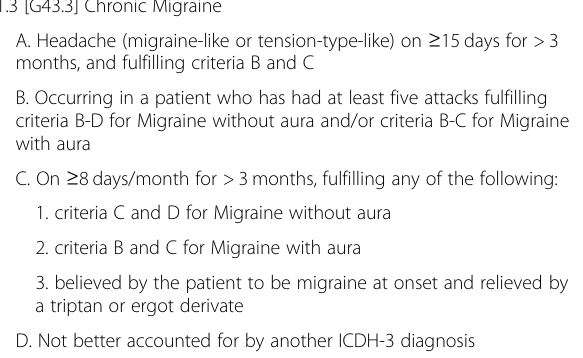
Table 4 Classification of chronic migraine